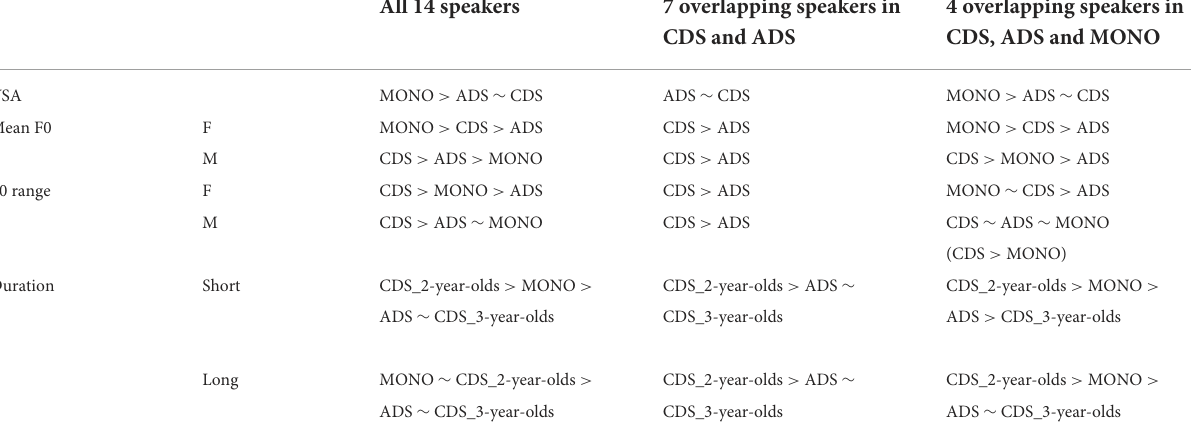
TABLE 8 Comparisons of vowel space area (VSA), F0 mean and range, and vowel duration for CDS, ADS and MONO dataset. All 14 speakers 7 overlapping speakers in 4 overlapping speakers in CDS and ADS CDS, ADS and